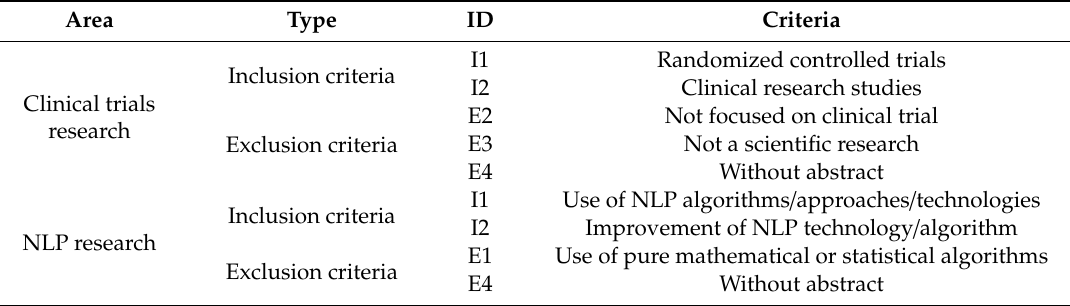
Table 2. Examples of inclusion and exclusion criteria for the manual verification.